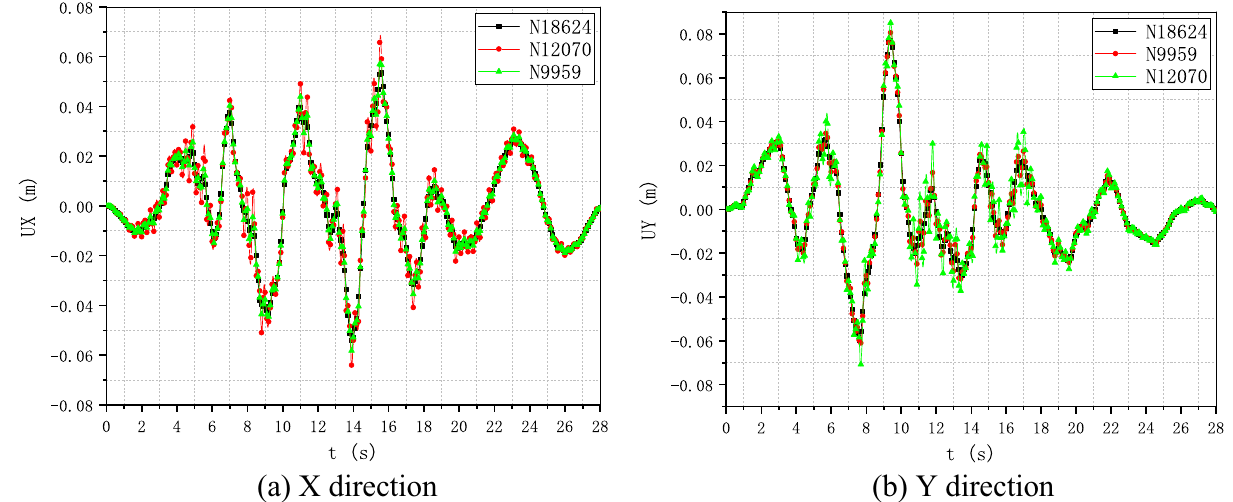
Figure 26. Horizontal displacement histories of monitoring points at different heights (33.576 m, 69.671 m, 116.916 m). ( a ) X direction, ( b ) Y direction.